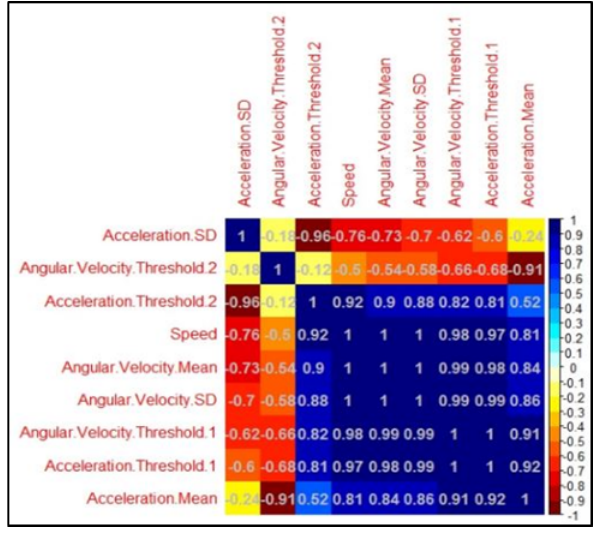
Figure 6 . Features' Correlation